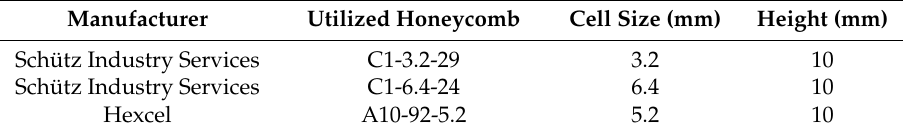
Table 3. Tabular listing of the aerospace qualified honeycomb used [20,21].